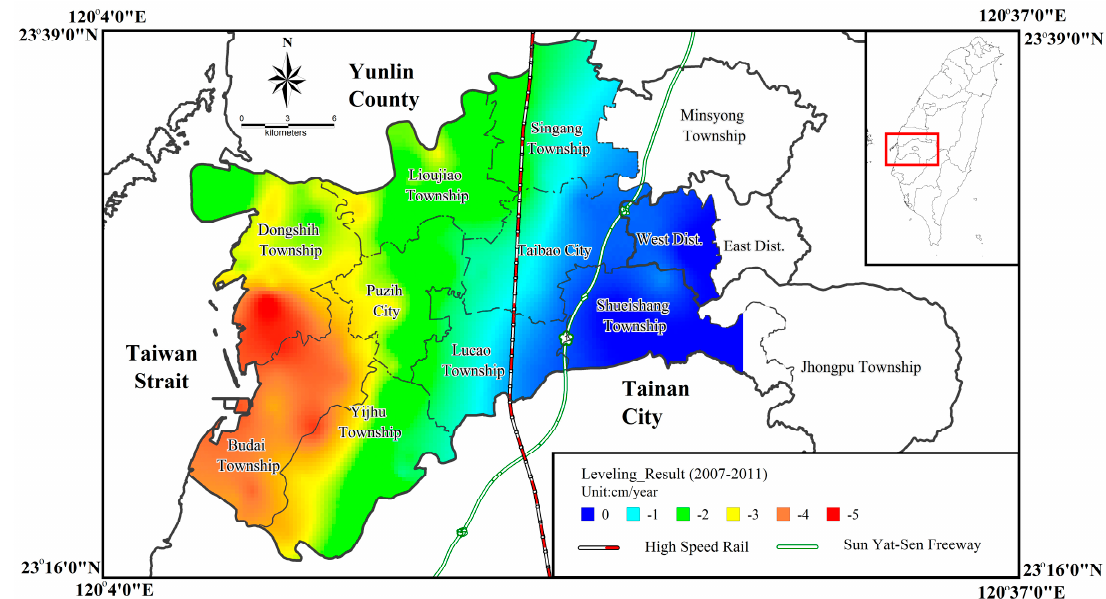
Figure 5. Areal rates of vertical displacement interpolated from point measurements of precision leveling over 2007–2011. The rates show significant subsidence (with an opposite sign to vertical rate of displacement) in the coastal area of Chiayi, despite the discontinuities caused by sparse points.